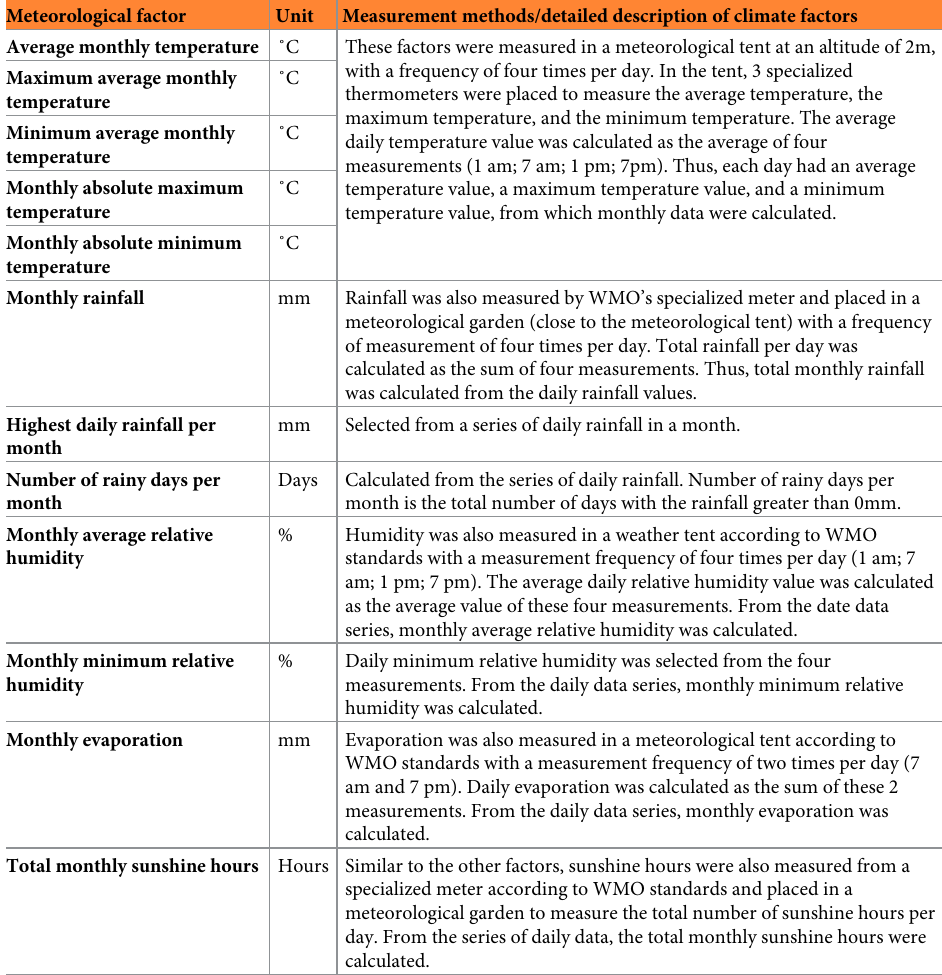
Table 1. Meteorological factors from the Vietnam Institute of Meteorology, Hydrology and